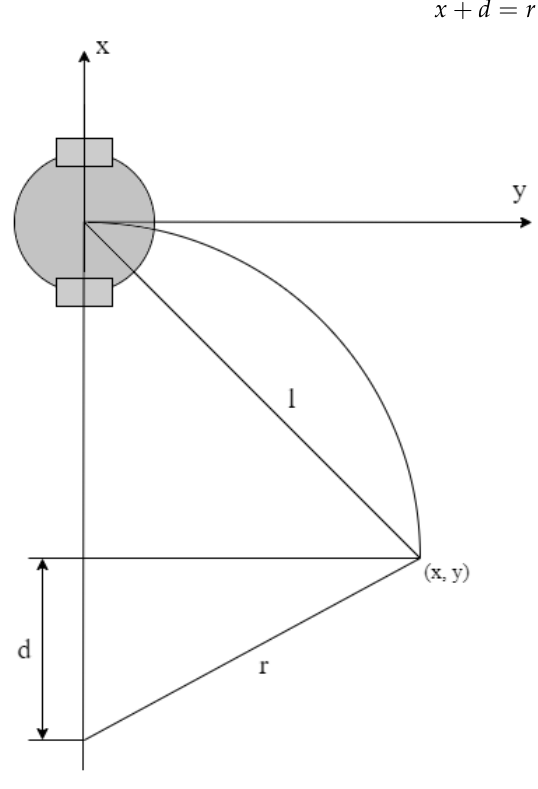
Figure 3. Geometric representation of the Pure Pursuit algorithm